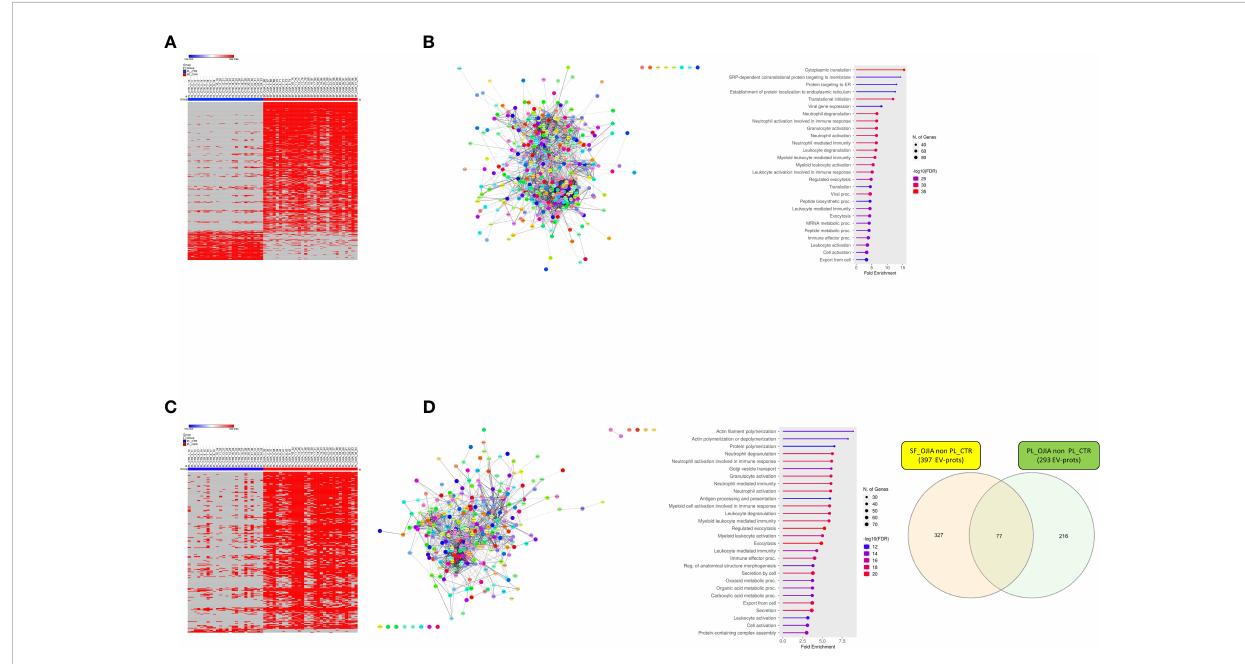
FIGURE 6 Analysis of the distribution of missing values in SF_OJIA vs PL_CTR and PL_OJIA vs. PL_CTR. Distribution of missing values between the full sets of OJIA and CTR samples was assessed by a two sample Z-test for proportions, and EV-prots exclusively expressed in SF_OJIA and PL_OJIA were subjected to network and functional enrichment analyses. (A, C) Heat-map representations show detectable and missing values across samples. Each column corresponds to a sample (indicated on the top side) and each row represents a differentially expressed protein derived from the comparison. The blue and red bars above the columns distinguish the OJIA and CTR groups. Proteins with z-test scores lower than -4.0 or higher than 4.0 (p<0.00005) were considered to have statistically signi fi cant differences between groups. Heatmap was drawn using global coloring. A good association between clusters of EV-prots exclusively expressed in SF_OJIA (A) and PL_OJIA (C) respect to PL_CTR and vice versa is shown. (B, D) Network and pathway enrichment analyses were carried out on EV-prots uniquely expressed in SF (B) and PL (D) samples respect to PL_CTR. Functional interaction networks among EV- prots and GO enriched biological processes are depicted as detailed in the legend of Figures 3C, D. (E) Venn diagrams show the number of common and exclusive EV-prots detectable between the comparisons of paired SF_OJIA and PL_OJIA respect to PL_CTR specimens. Each comparison is depicted by a distinct color. The signi fi cance of the overlapping was estimated with hypergeometric